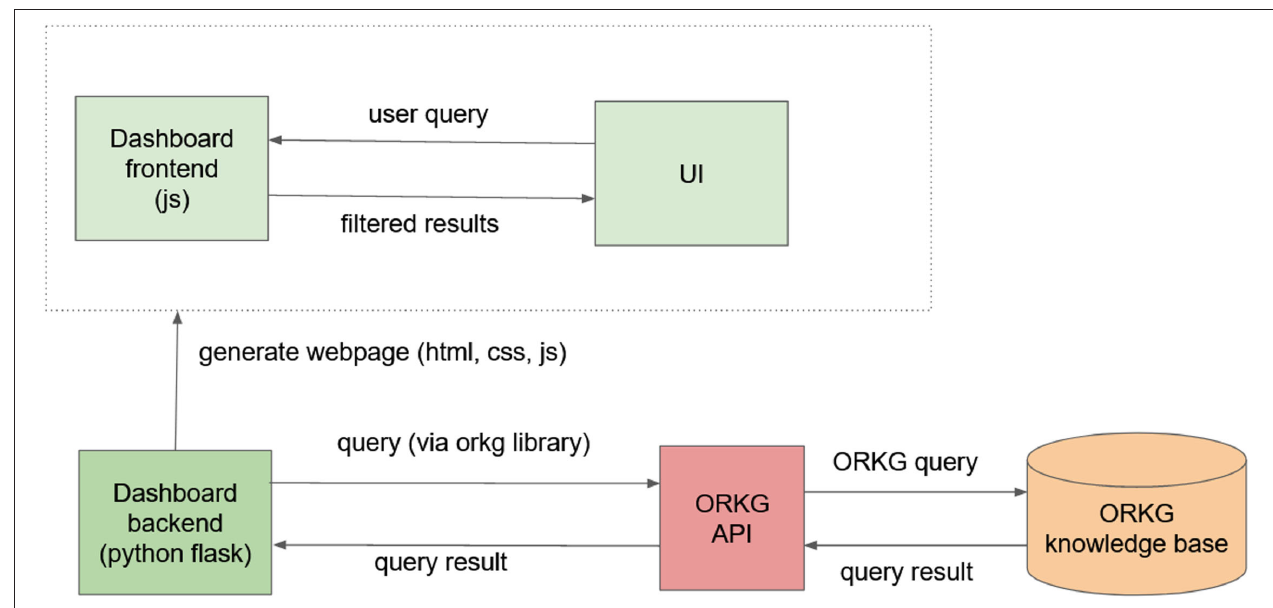
FIGURE 1 | System architecture. ORKG, Open Research Knowledge Graph; UI, user interface; API, application programming